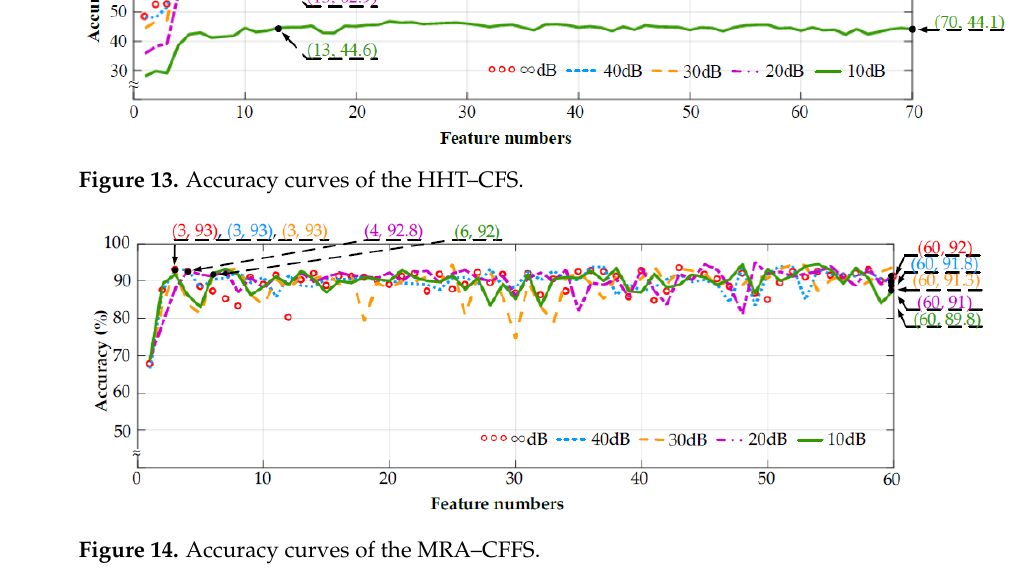
Figure 14. Accuracy curves of the MRA–CFFS.